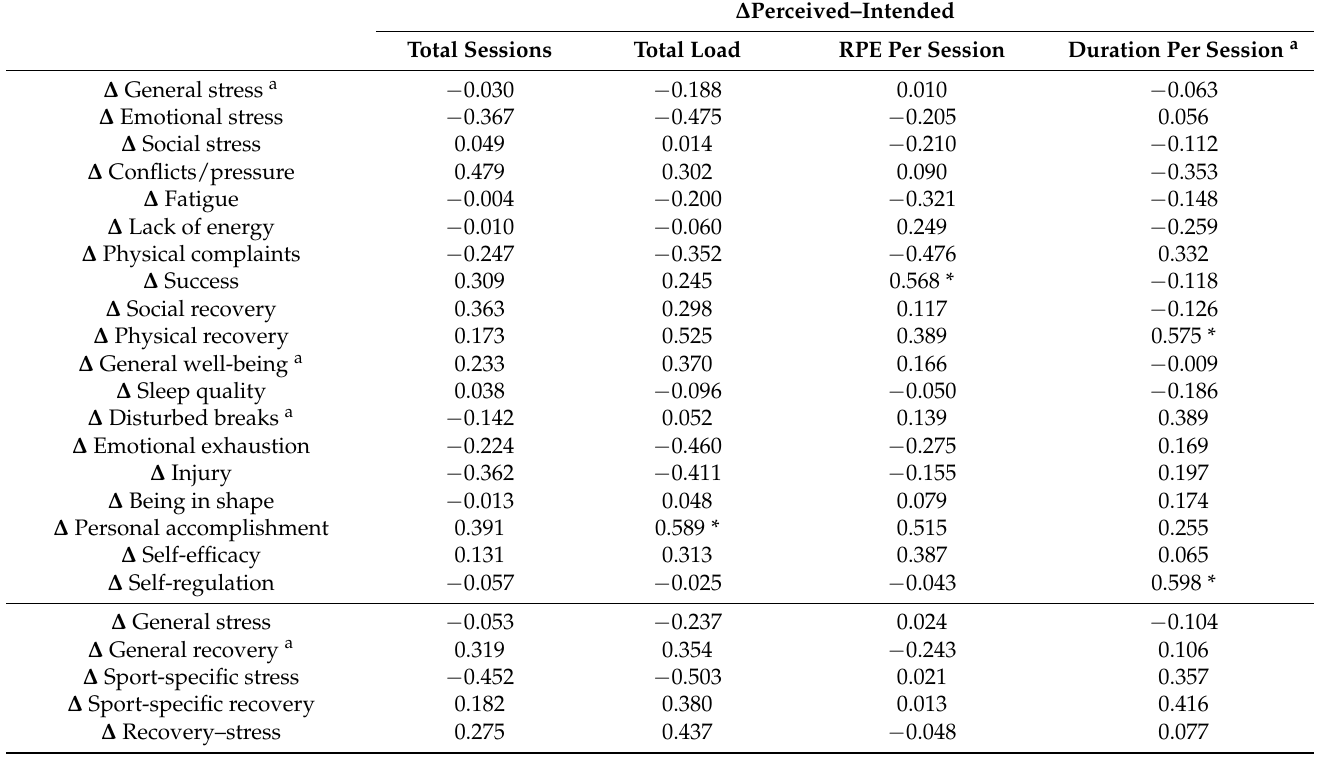
Table 3. Pearson and Spearman correlations between change scores for the RESTQ-sport (post minus pre) and differences between intended and perceived training variables (perceived minus intended) of 14 speed